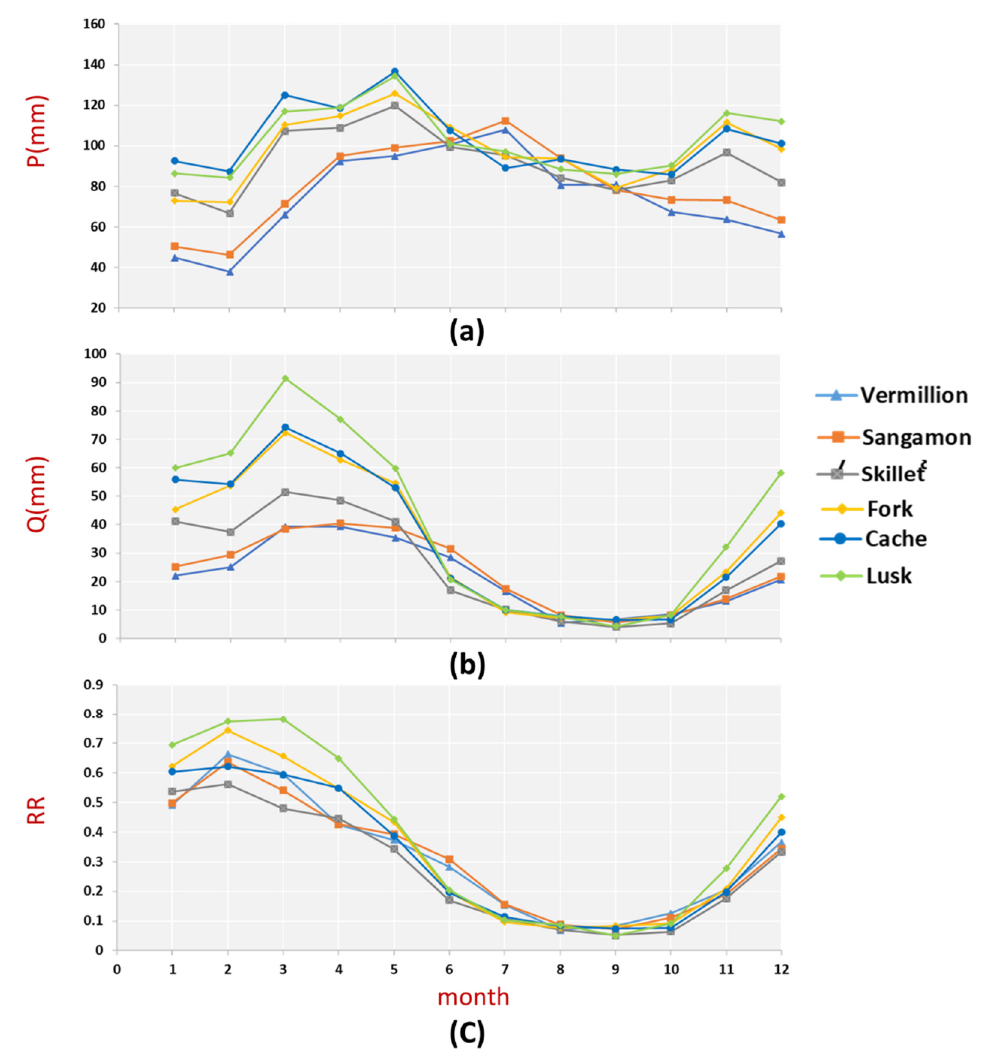
Figure 5. Seasonal pattern of the ( a ) precipitation (P), ( b ) runoff (Q), and ( c ) runoff ratio (RR).